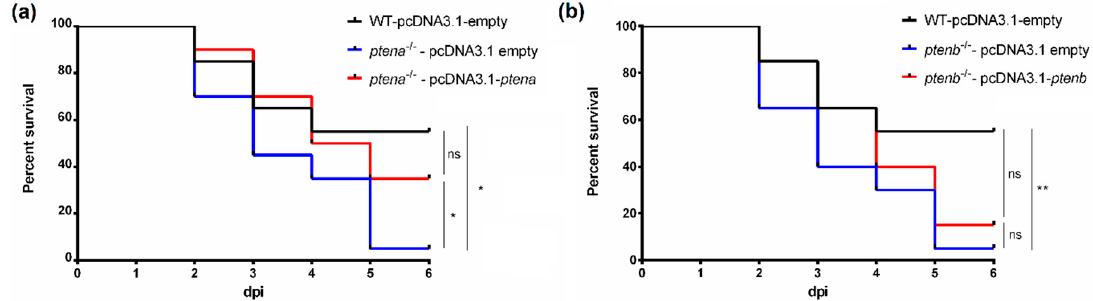
Figure 8. Kaplan–Meier survival curves representing the effect of the ptena gene rescue in ptena -/- zebrafish embryos ( a ) and the ptenb gene rescue in ptenb -/- zebrafish embryos ( b ) during bath challenge with SVCV. No mortality events were recorded for the uninfected controls. Statistically significant differences were determined with a log-rank (Mantel–Cox) test and are displayed as ** (0.001 < p < 0.01) or * (0.01 < p < 0.05); ns: non-significant di ff erences.